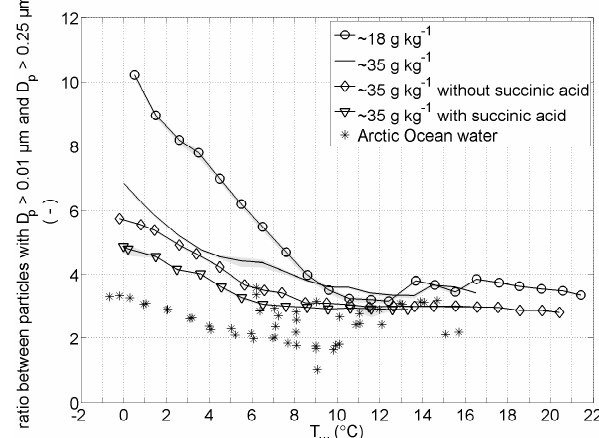
Fig. 4. Ratio between particles D p > 0.01µm and D p > 0.25µm for waters with different salinities and organic content as a function of water temperature ( T w ). For comparison data from Arctic Ocean water is shown in addition. Grey shaded areas indicate the 25th and 75th